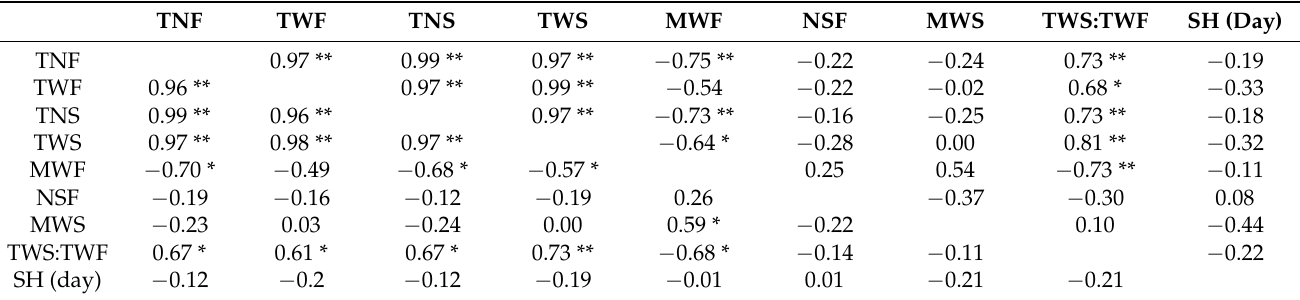
Table 3. Genotypic (upper diagonal) and phenotypic (lower diagonal) correlations between fruit production and quality traits in 12 sacha-inchi